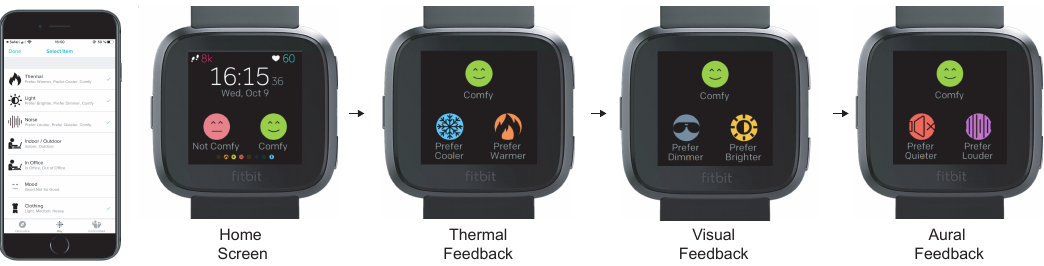
Figure 2. The cozie watch-face, built on the Fitbit smartwatch platform was used to collect subjective feedback. The phone that is paired with the Fitbit can be used to set up additional